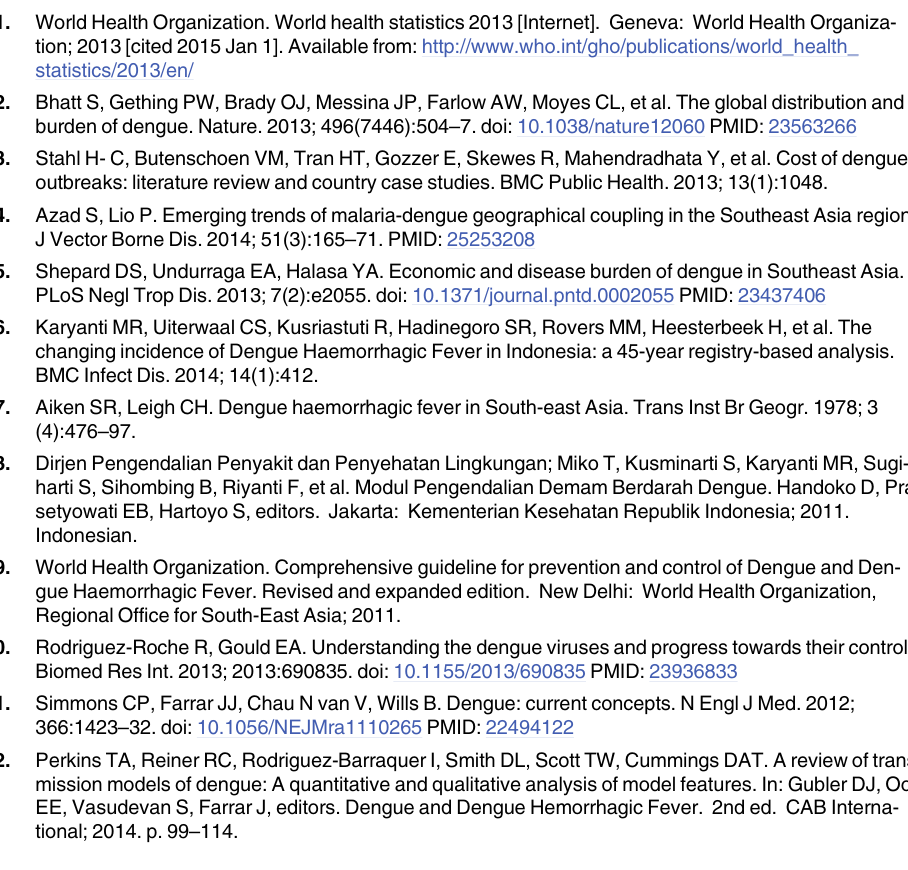
S1 Table. Initial Analyses